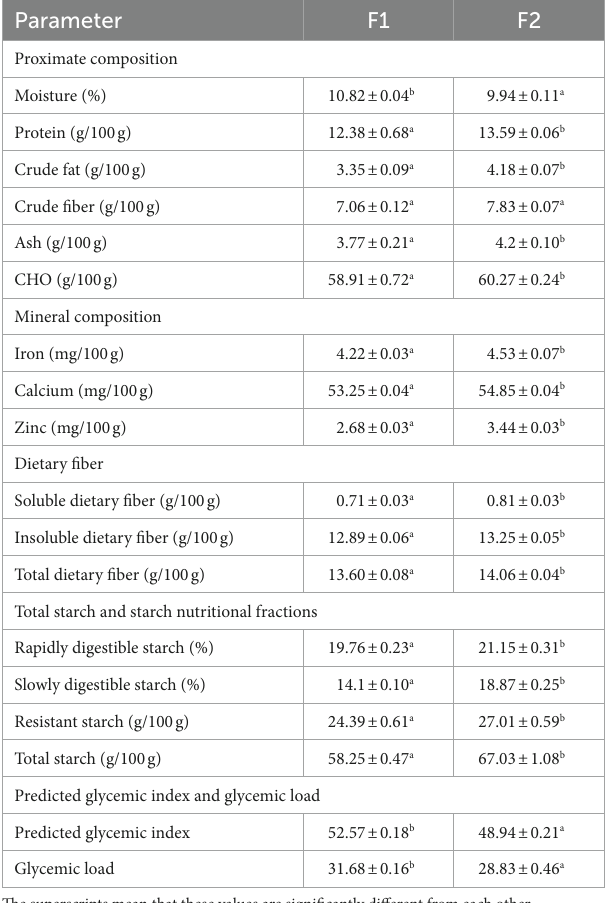
TABLE 2 Nutritional composition of Foxtail millet germplasm lines (on dry weight basis).